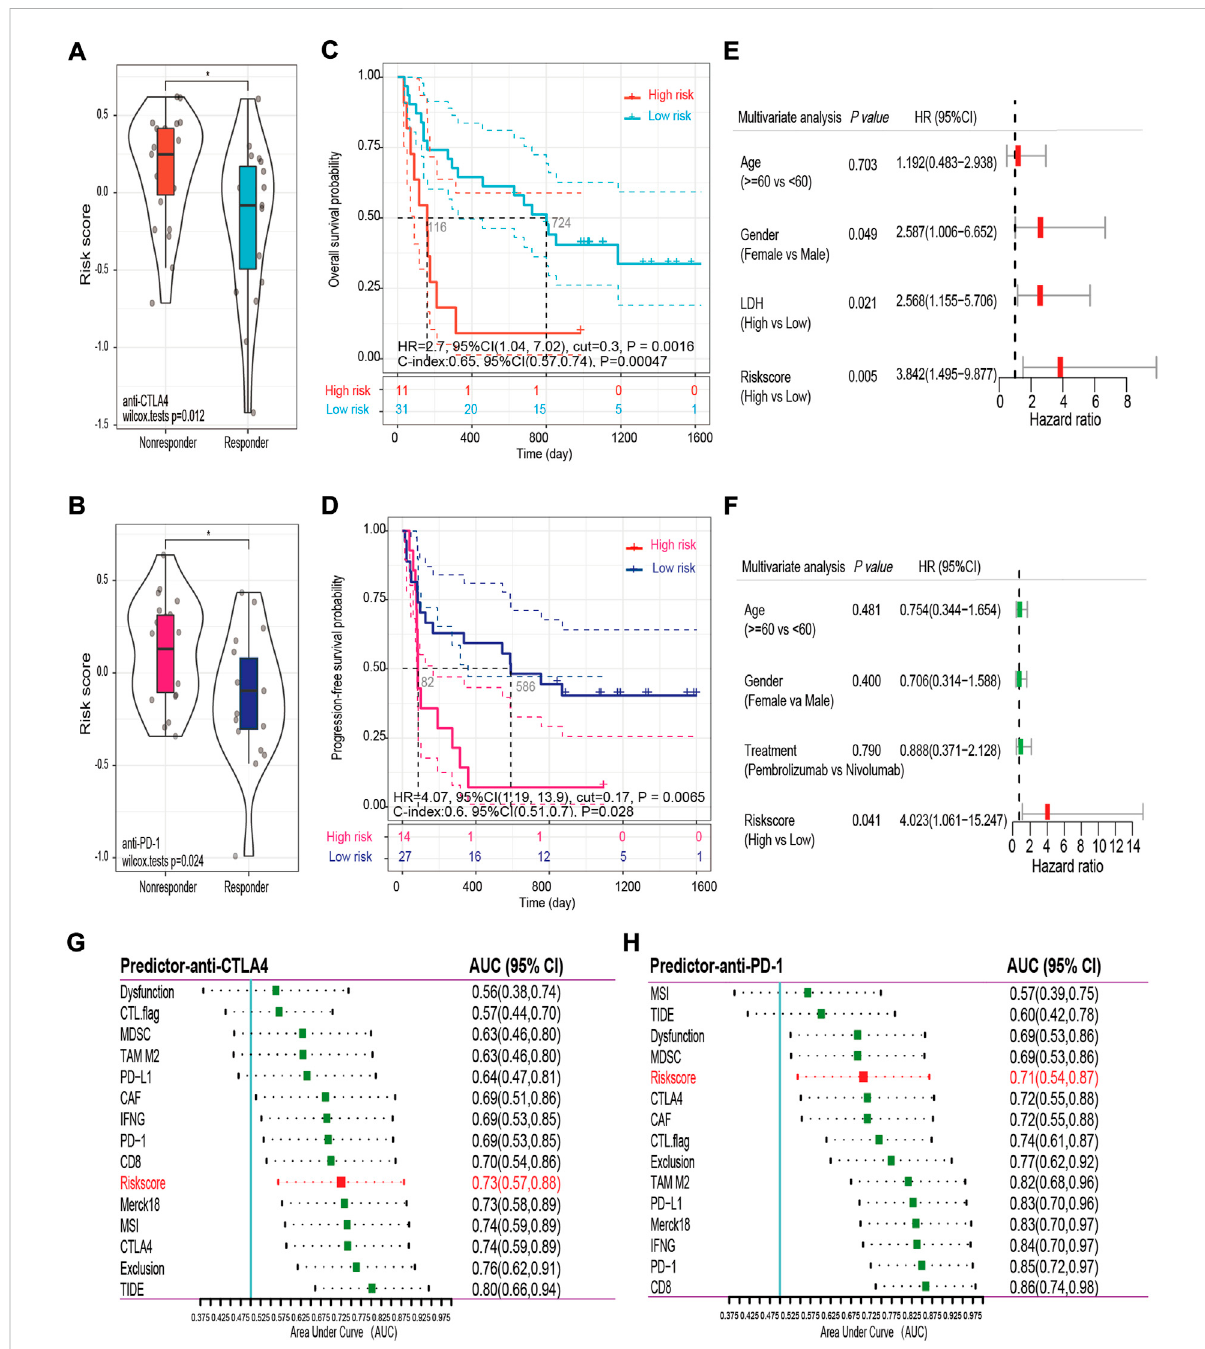
FIGURE 12 Validation and comparison of the predictive performance of the risk score in the anti-CTLA4 (A,C,E,G) and anti-PD-1 (B,D,F,H) cohorts. Distributionsoftheriskscoresinthenon-responderandrespondergroupsaredisplayedinviolinplots (A,B) .Kaplan – MeiercurvesforOS (C) andPFS (D) in the different groups. Forest plots of the multivariable Cox regression analysis with HR and 95% CIs (E,F) . AUC values and 95% CIs for the 15 predictors are shown in the forest plots (G,H) . OS, overall survival; PFS, progression-free survival; HR, hazard ratio; CI, con fi dence interval; AUC, area under the curve; TIDE: tumor immune dysfunction and exclusion score; IFNG: normalized average expression of IFN- γ response biomarkers, including HLA-DRA, CXCL10, IDO1, STAT1, and IFNG; MSI: microsatellite instability score predicted from gene expression through ridge regression; Merck18: Tcell-in fl amed signature (PMID: 28650338); PD-L1, PD-1, CTLA4: gene expression valuesof CD274, PDCD1 and CTLA4; CD8: average expression value of CD8A and CD8B; CTL fl ag: fl ag indicator for whether gene expression values are all positive for fi ve cytotoxic T lymphocyte markers, including PRF1, GZMB, GZMA, CD8B, and CD8A; Dysfunction, Exclusion: enrichment scores based on the gene expression signatures of T-cell dysfunction and T-cell exclusion; TAM M2, MDSC, CAF: Pearson correlation coef fi cients between expression pro fi le and M2 tumor-associated macrophages, myeloid-derived suppressor cells, and cancer-associated fi